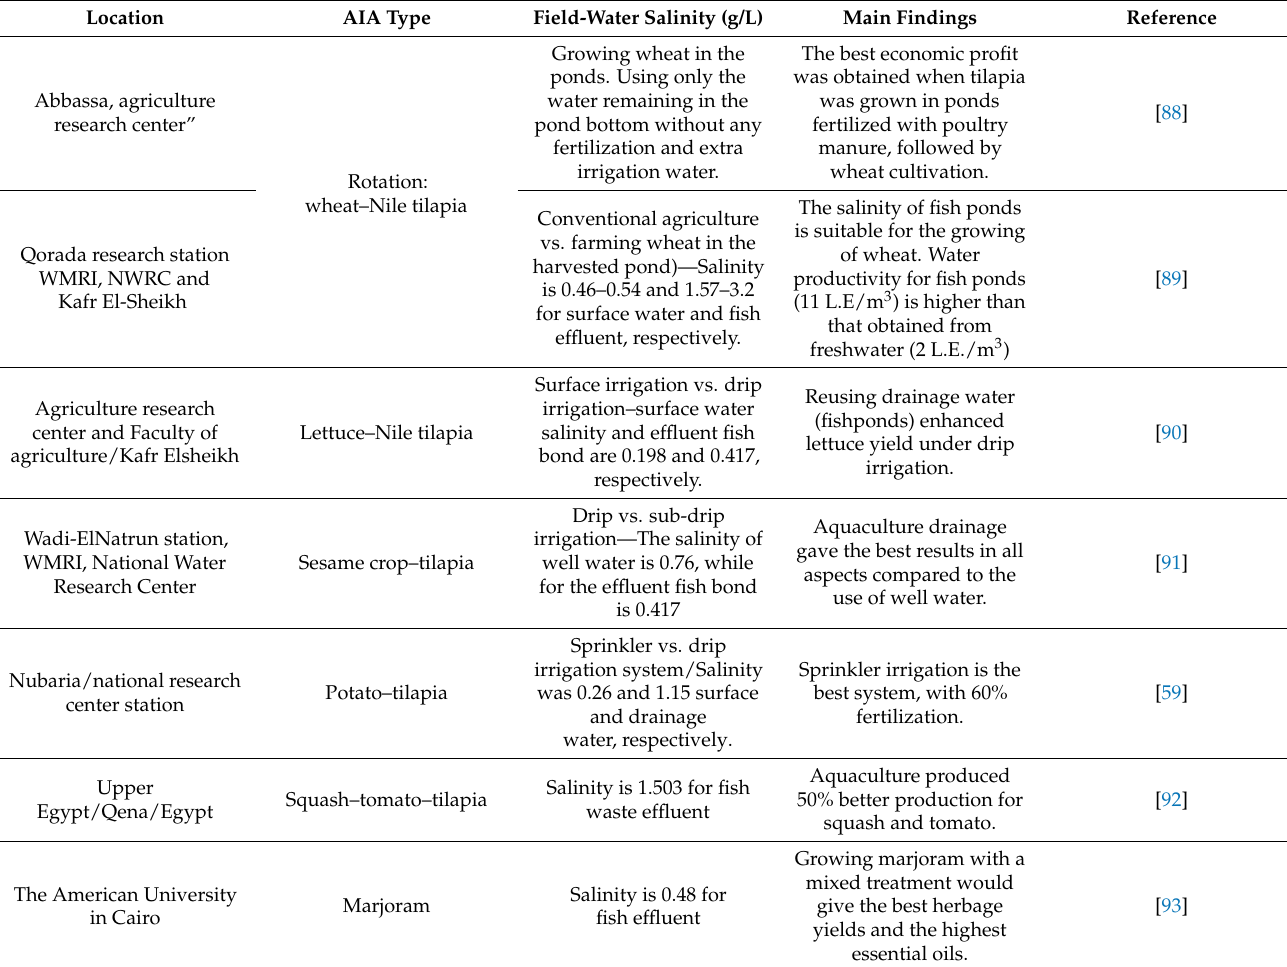
Table 9. National experience on